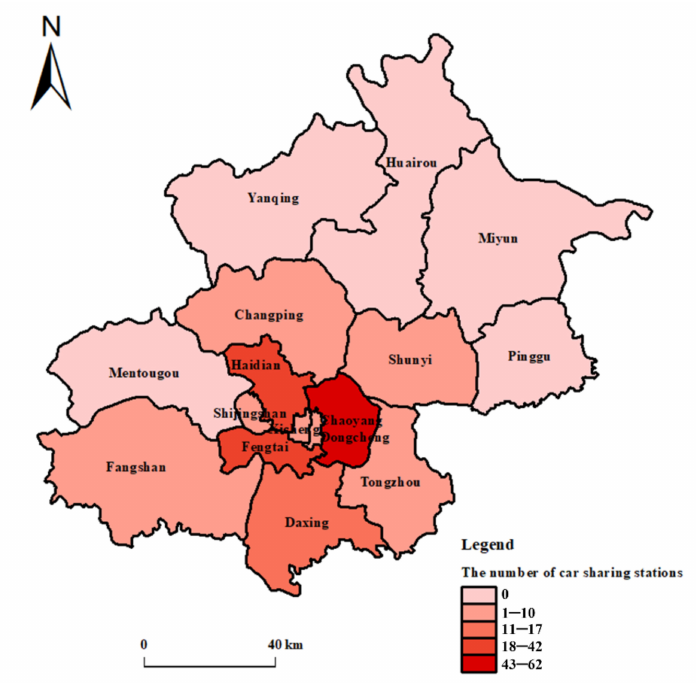
Figure 2. The distribution of car sharing stations in